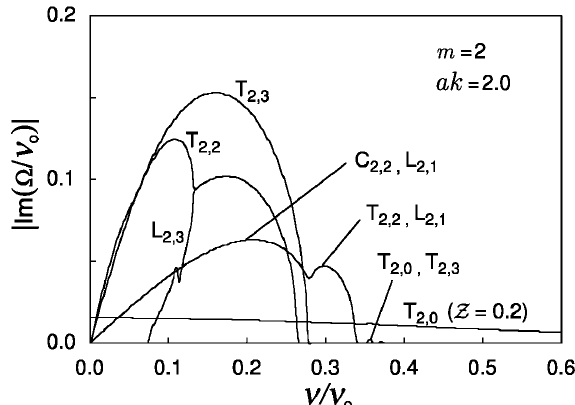
FIG. 10. Absolute value of the imaginary part of (cid:13) =(cid:10) the first 18 quadrupole modes as a function of (cid:10)=(cid:10) 2 : 0 , b=a (cid:3) 1 : 5 , and zero wall impedance. Only the modes with none-zero Im (cid:1) (cid:13) =(cid:10) value of the imaginary part of (cid:13) =(cid:10) case of Z (cid:3) 0 : 2 . The kink in the L due to a confluence of L